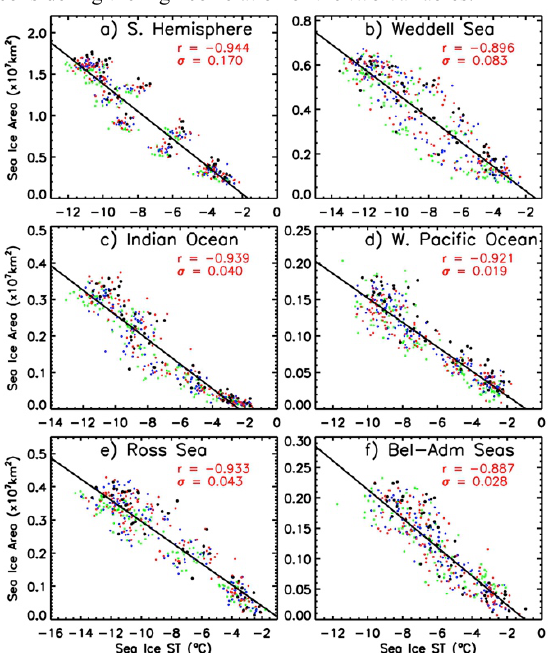
Figure 11. Scatter plot of surface temperature versus sea ice area in the (a) Antarctic region and (b-f) the various Antarctic sectors. Figure 12. (a) Yearly averages of the Southern Hemisphere Annular Mode indices during the winter period and monthly (b) surface temperature and (c) sea ice extent anomalies from 1978 to